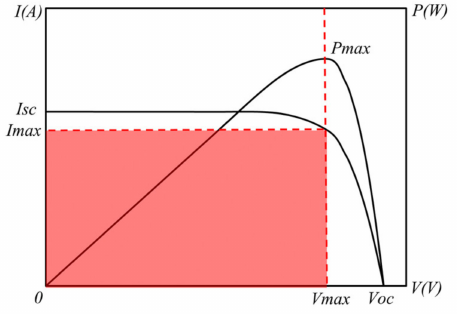
Figure 2. Electrical properties of the solar cells when exposed to solar irradiance.